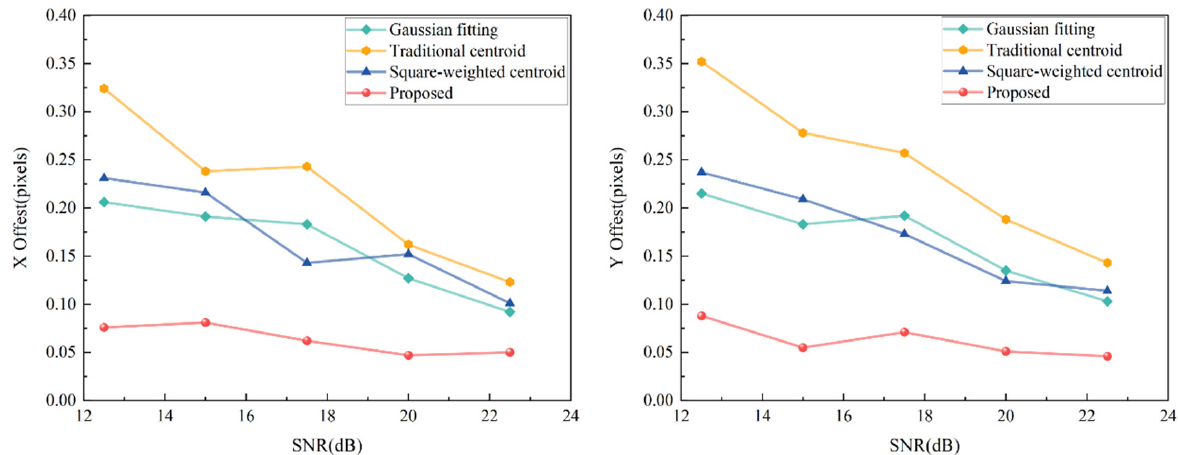
Figure 7. Deviation of the center locating results of several algorithms from the true center in the x- and y-directions.